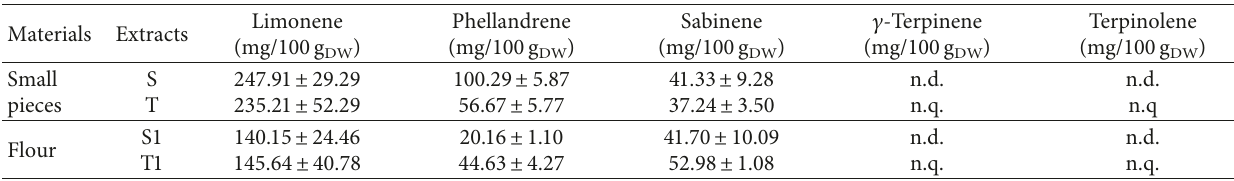
Table 5: Monoterpene composition of different breadfruit extracts.